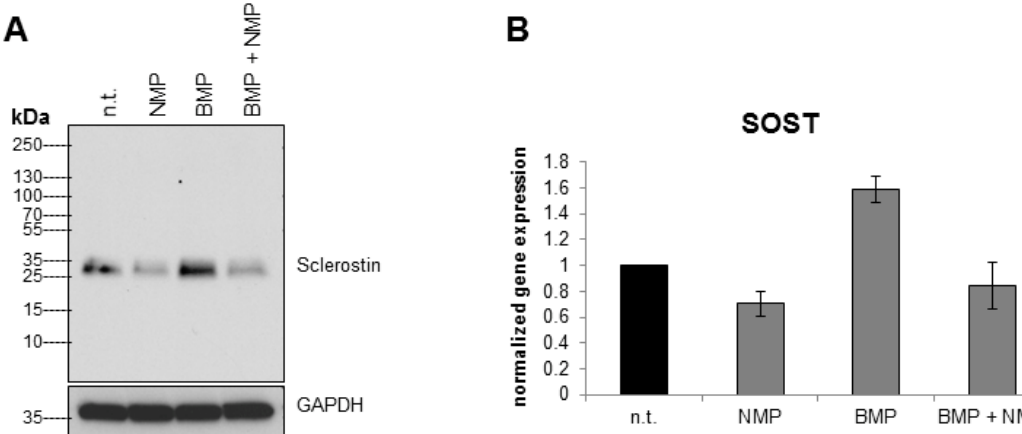
Figure 3. NMP prevents the BMP-2 induced increase in sclerostin expression. Stimulation of UMR-106 cells with 500 ng/mL bone morphogenetic protein 2 (BMP-2) increases sclerostin protein at 8 h ( A ) whereas a combination of BMP-2 and 2 mM NMP decreases sclerostin protein. Illustration of qRT-PCR of the same treatment is presented in ( B ).